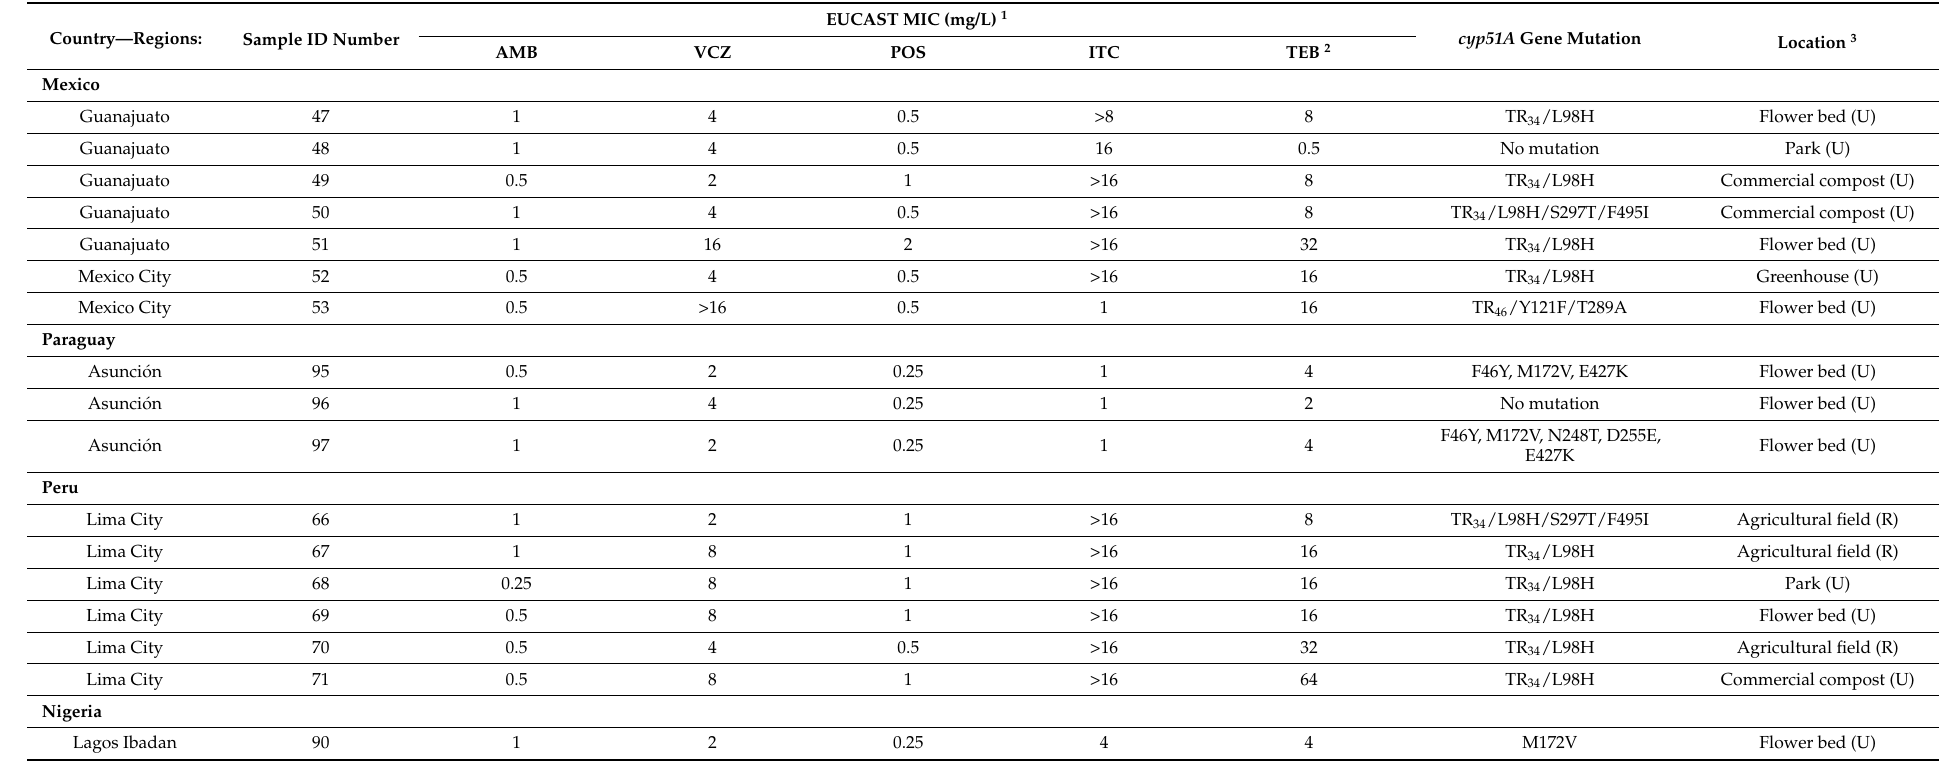
Table 2. Mycological characteristics of triazole-resistant Aspergillus fumigatus environmental